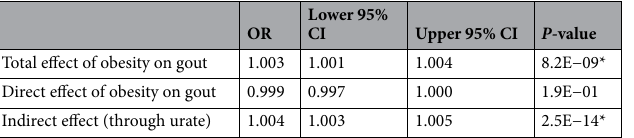
Software. The IVW and sensitivity estimations were performed in R version 3.6.2 with the “TwoSampleMR” package 17,33 . The multivariable MR analysis was performed using the “mv_multiple” function for generating IVW estimates, also within the “TwoSampleMR” package, after clumping for LD (PLINK clumping method with 10,000 kilobase [kb] window; R 2 of 0.001), harmonizing 21 , and removing outlier SNPs (identified with “RadialMR”), which had been removed in the univariate analyses. The standard error for the indirect effect was approximated with the delta method 32 . Genetic correlations were calculated using the ldsc software (available at